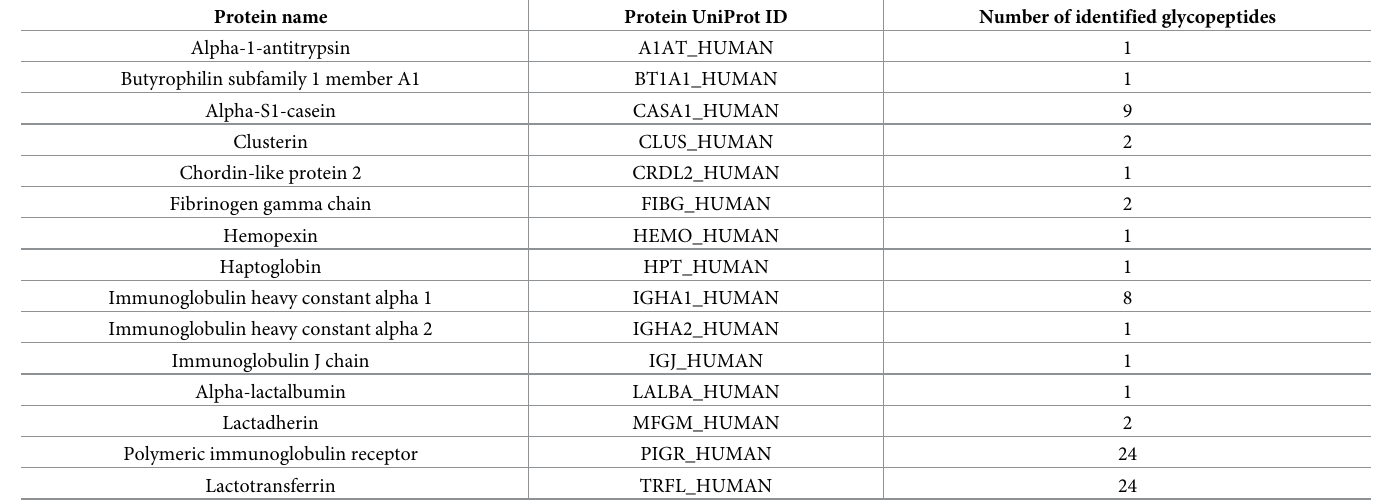
Table 1. Summary of